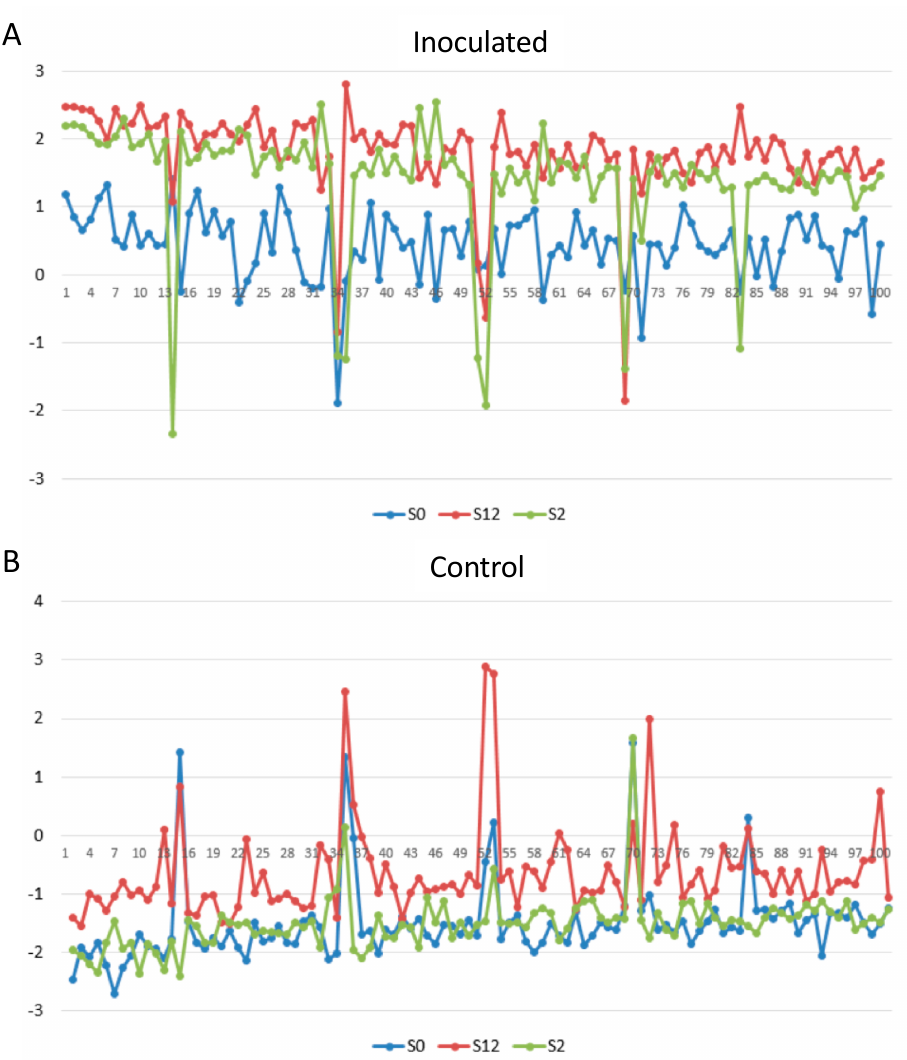
Figure 8. Top 100 differentially expressed genes ( X -axis) for Baudin NILs containing S12 ( mlo-11 ), S2 ( mlo-11 ( cnv2 )), and S0 ( Mlo ) during ( A ) infection by Bgh and ( B ) noninoculated control samples, represented through variance-stabilizing transformation (VST) z -score ( Y -axis).